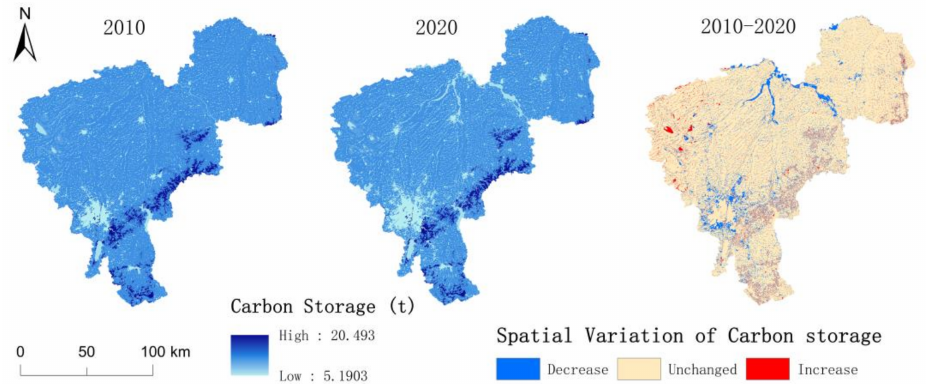
Figure 5. Spatial distribution and variation of carbon storage in Changchun from 2010 to